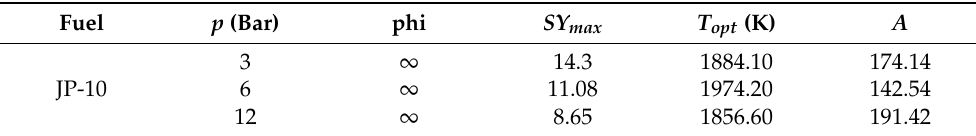
Table 5. The maximum soot yields and the corresponding temperatures of the JP-10 fuel under different